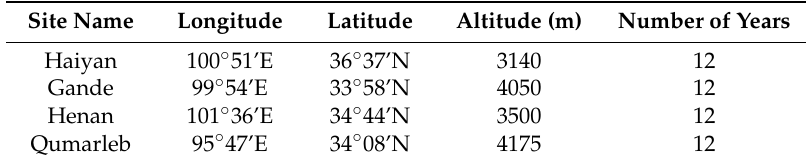
Table 1. Summary of ground-observed phenology data of Kobresia humilis